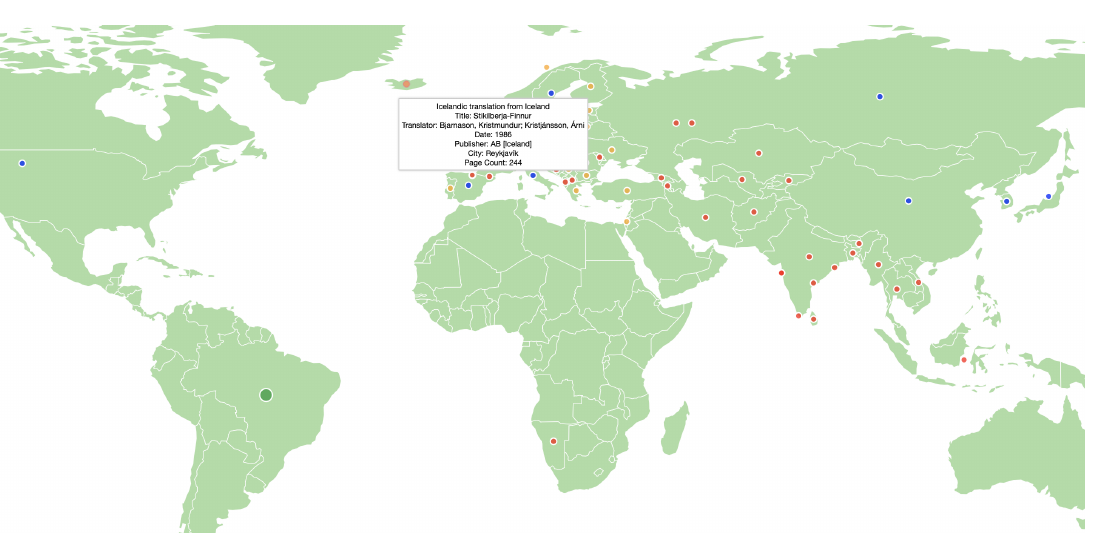
Figure 3. The global knowledge Map representing existing translations of Adventures of Huckleberry Finn. In this map, the bubble over Iceland is highlighted, displaying the relevant information for the Icelandic